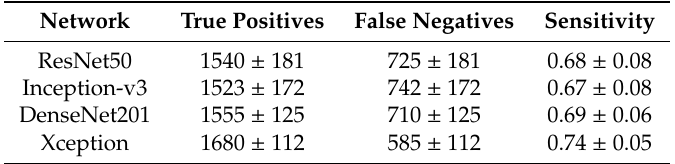
Table 7. Test Performance using baseline method on the BIMCV